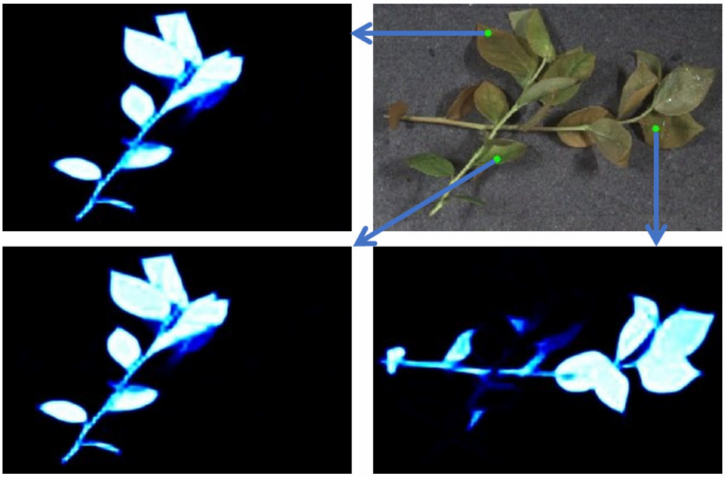
Figure 5. Instance segmentation masks produced by AdaptIS for various point proposals. AdaptIS optimizes a target loss function for a given image I and a proposed point at image coordinate (x, y). It uses a pixel-wise loss function for comparing the prediction with the mask of the target object located at the point (x, y). Since AdaptIs provides pixel-precise segmentation, it is suitable for objects with complex shapes and can handle cases of heavy occlusion